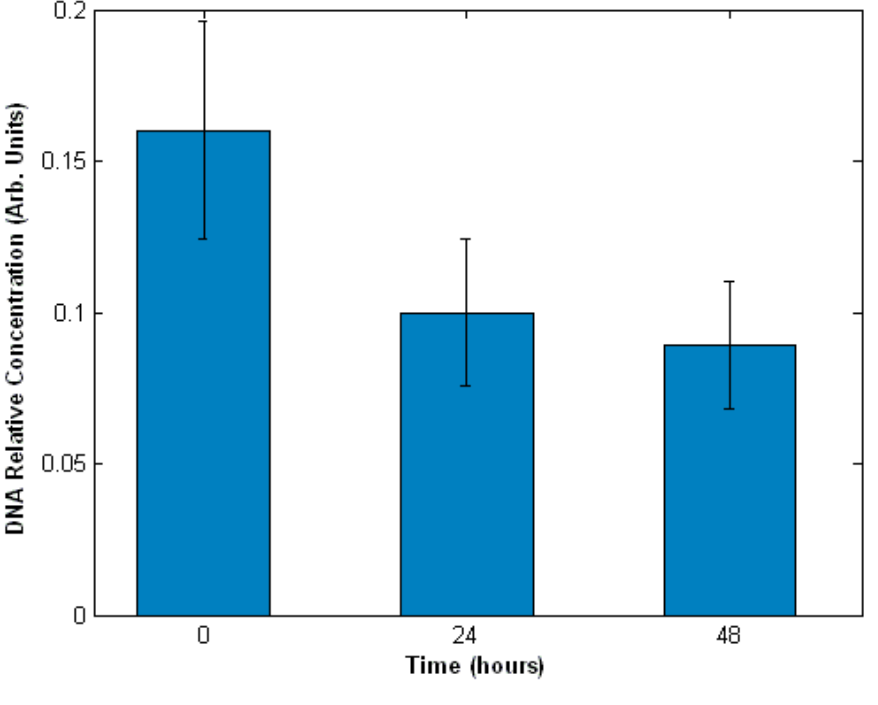
Figure 4 . Damage to DNA caused by exposure of A549 cells to